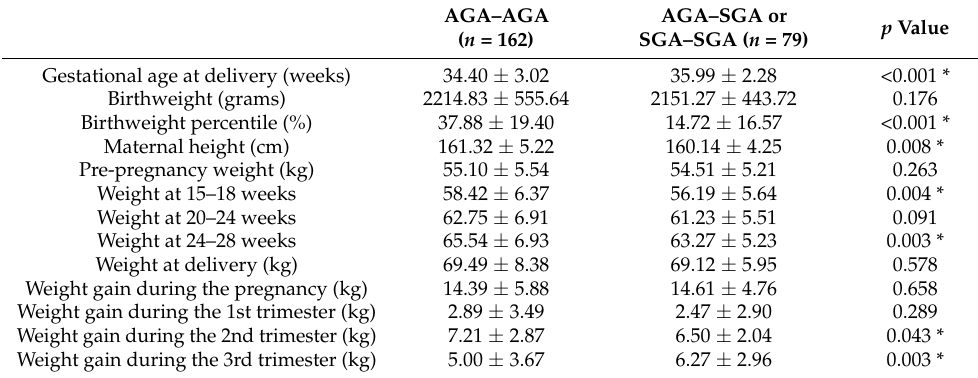
Table 4. Comparisons on maternal weight and weight gain according to gestational age between